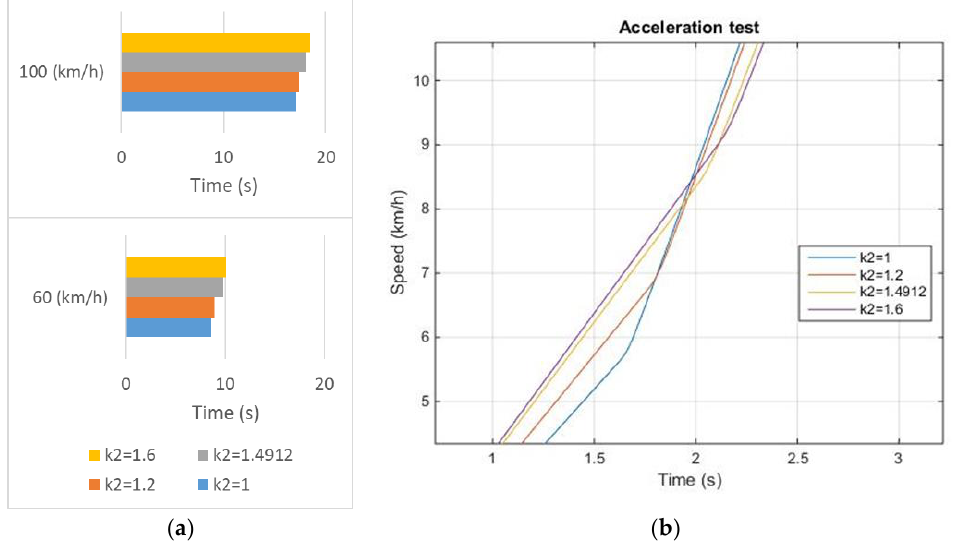
Figure 18. ( a ) Acceleration time compared with different 𝑘 2 values. ( b ) Acceleration in mode change phase (EV to ICE).